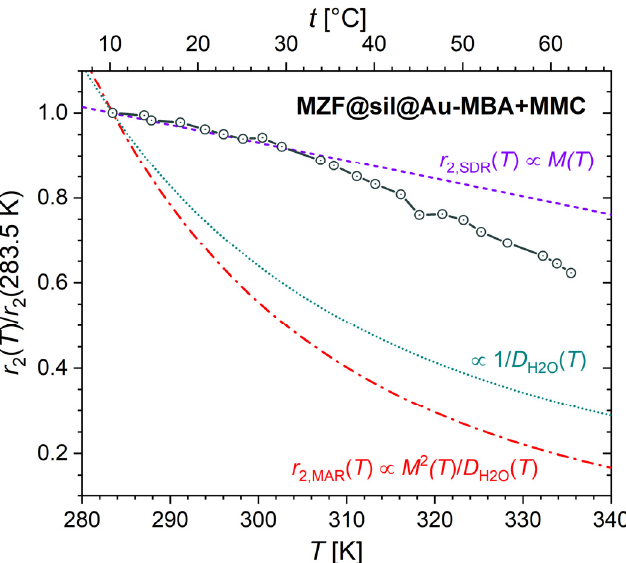
Figure 10. Temperature dependence of transverse relaxivity, r 2 , normalized by using the value at the lowest experimental temperature, r 2 (283.5 K), for MZF@sil@Au-MBA+MMC nanoshells in the magnetic field of 0.47 T. The dependence is compared with the dependences predicted for SDR (r 2,SDR ) and MAR (r 2,MAR ) and with the temperature dependence of the inverse value of the self-diffusion coefficient of water 1/D H2O (T).